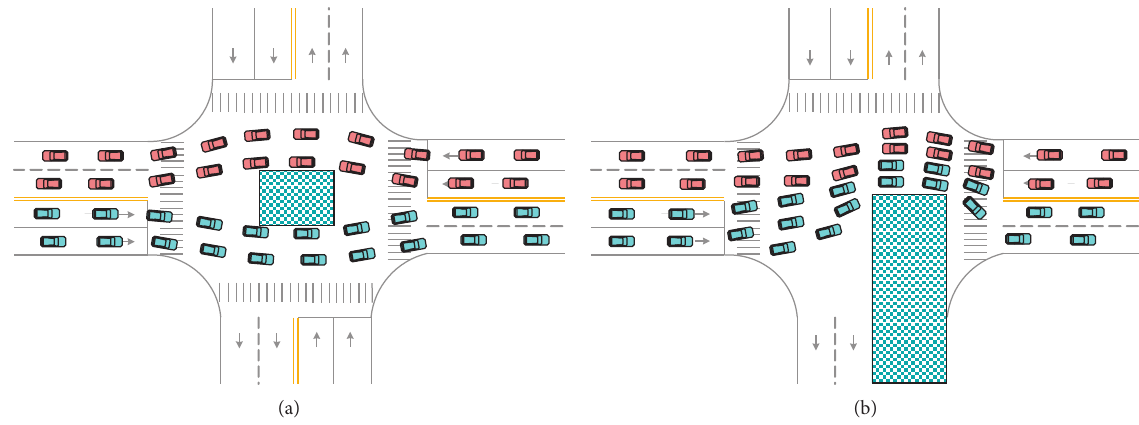
Figure 1: Two types of the intersection work zone. (a) Island work zone. (b) Straddling work